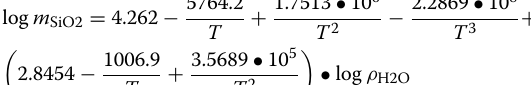
becomes linear when expressed as a function of the log ρ H2O (density of pure H 2 O). From regression analysis of their own data together with other published experimen- tal data over a range of temperatures, Manning (1994) arrived at an empirical expression that may be used to calculate the solubility in SiO 2 in H 2 O to perhaps 2 GPa total pressure;